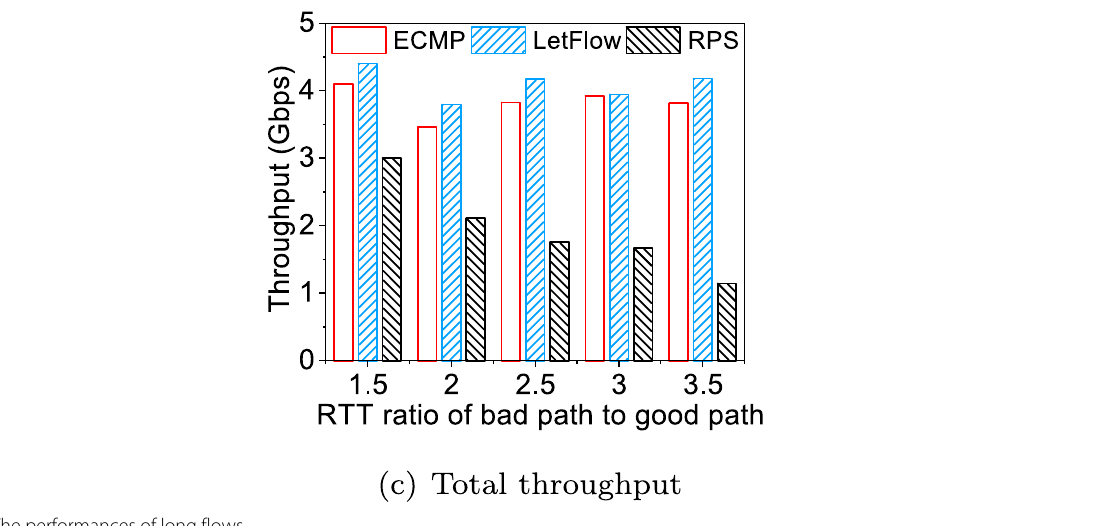
Fig. 3 The performances of long flows